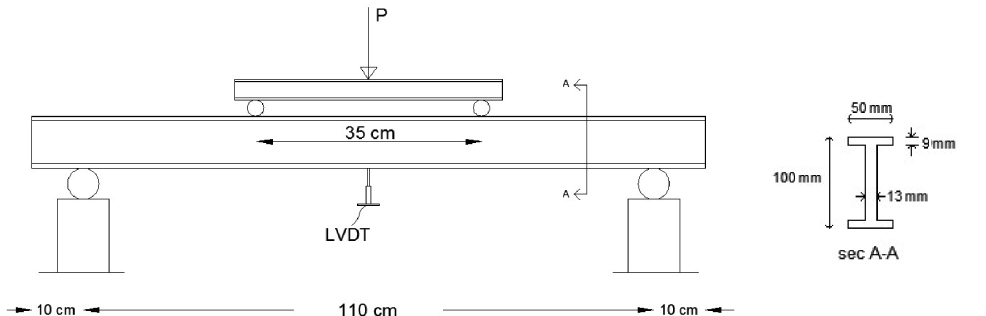
Fig. 2. Schematic representation of the four-point bending test Table 2. Material parameters and mechanical properties